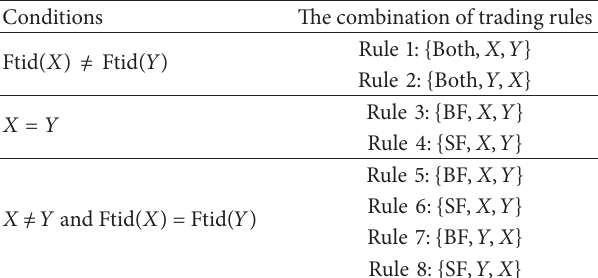
Table 3: The combination of trading rules using patterns 𝑋 and 𝑌 .